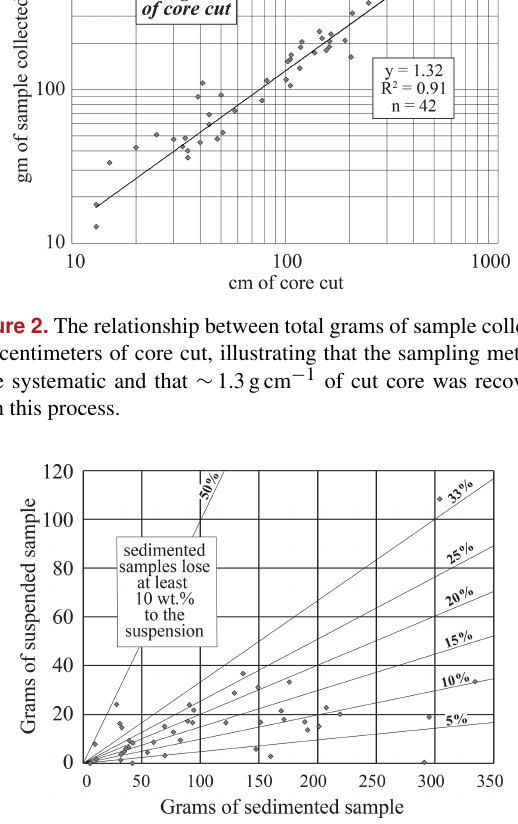
Figure 3. Graph comparing the weights of sedimented and sus- pended fractions in 42 core samples from Site 1415, Hess Deep. Equal weight fractions would follow the 50% line. The data show that the suspended sample was generally > 10% of the total sam- ple, but some samples produced a suspended subsample that was > 30% of the sedimented